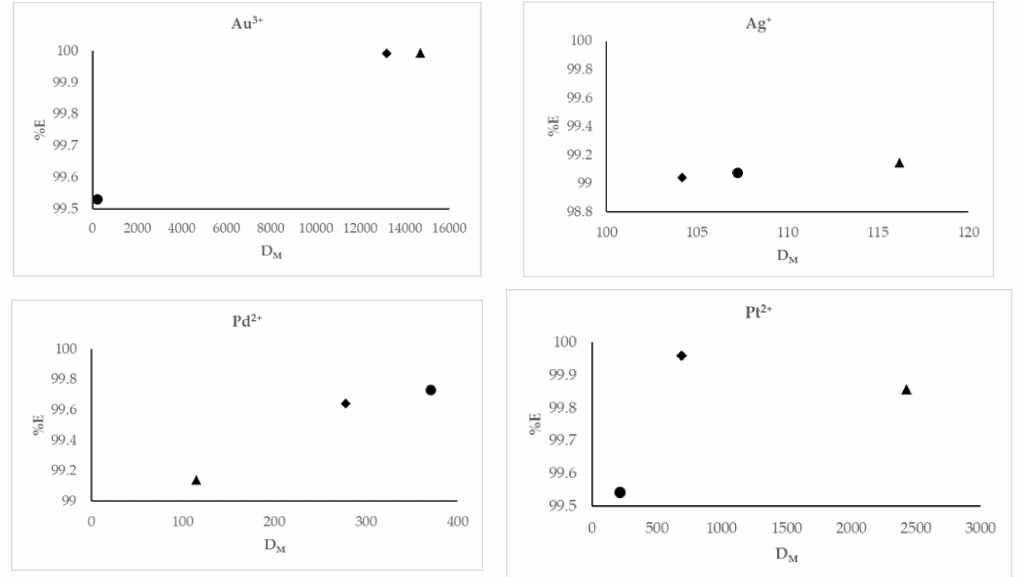
Figure 3. The dependence of the division ratio (D M ) on the extraction percentage (%E), where the • is related to the M:L ratio 1:1, the (cid:78) is related to the M:L ratio 1:5, and the (cid:7) corresponds to the M:L ratio 1:10. The given values of %E carry ± 0.03 and D M carry ±